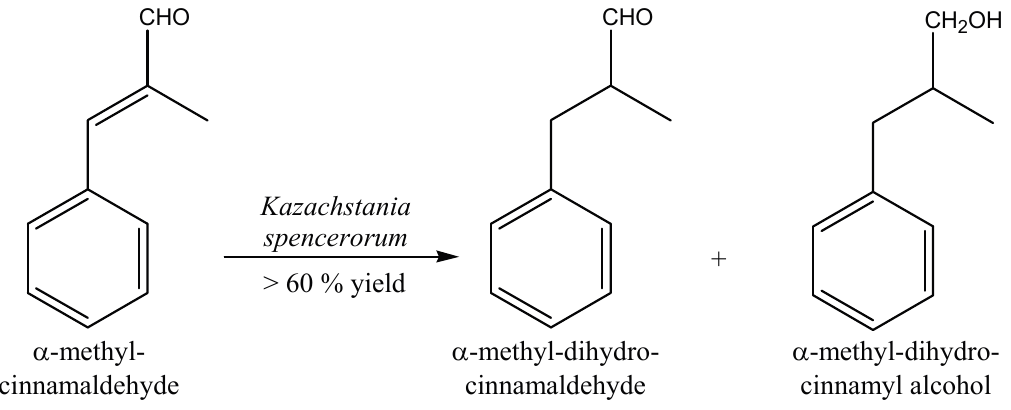
Figure 7. Bioconversion of α -methyl-cinnamaldehyde by NCY Kazachstania spencerorum